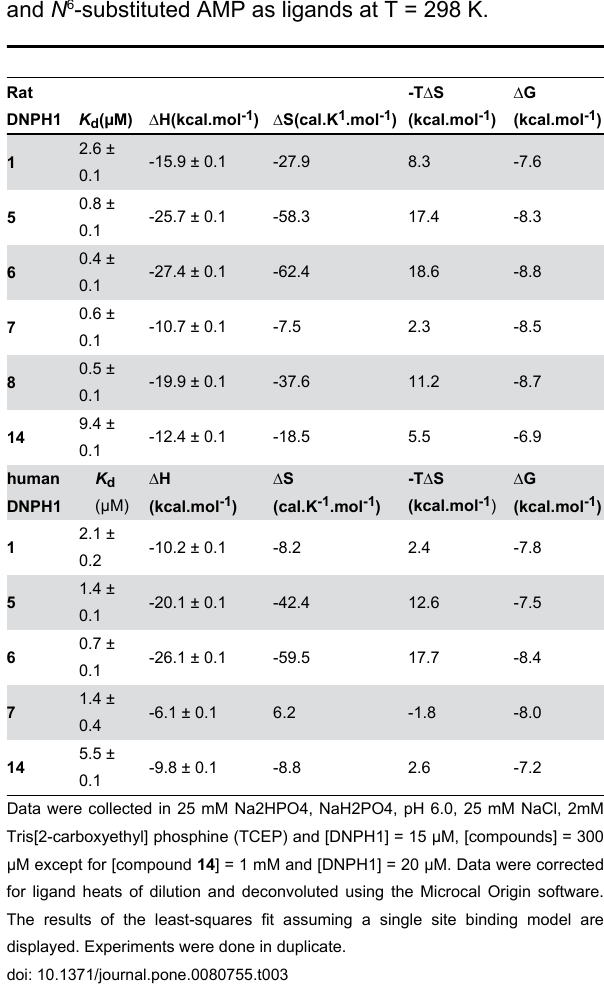
Table 3. Dissociation constants K DNPH1 with some cytokinin ribosides 5’-monophosphates and N 6 -substituted AMP as ligands at T = 298